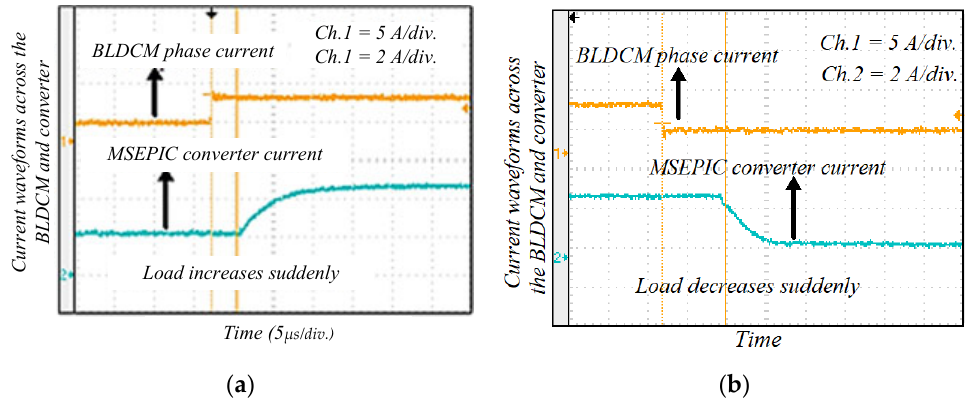
Figure 21. Experimental results of phase current and output voltage across the VSI unit during the dynamic conditions: ( a ) MI changes from 1.0 to 0.8; and ( b ) MI increases from 0.6 to 1.0.